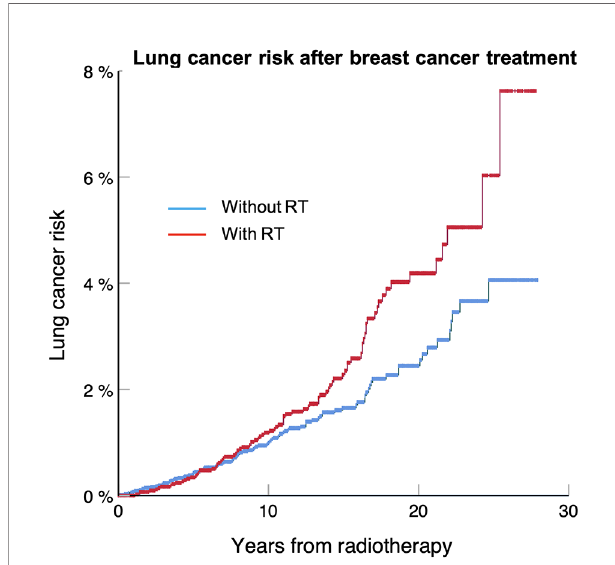
FIGURE 1 | Lung cancer free survival for DCIS treated with or without radiotherapy for patients included in the SEER 18 database between 1988 and 2012. The lung cancer risk at 25 years is 8.2% for patients treated with radiotherapy compared to 4.3% without (p <